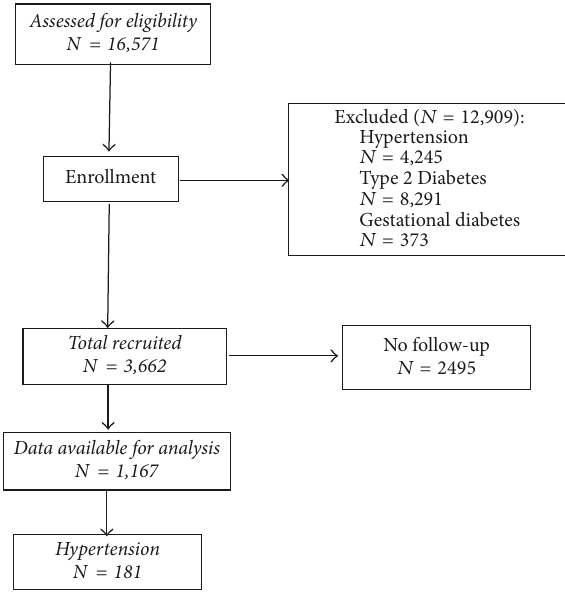
Figure 1: Schematic diagram of the study